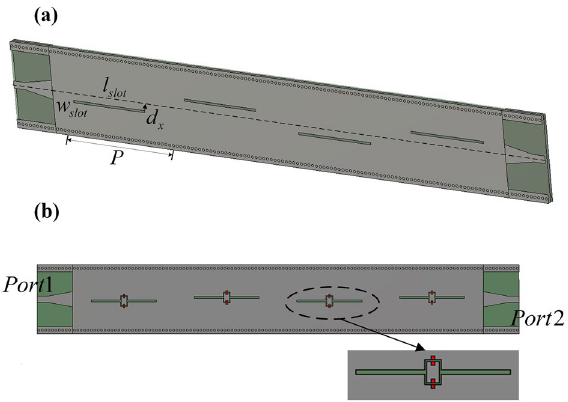
Figure 2. ( a ) The general view of a SIW-based slot antenna without on/off characteristics. Some optimized key parameters (length in mm) are: w slot = 0.5 , l slot = 18.4 , d x = 0.5 , P = 30. ( b ) SIW-based slot array with ideal on/ off characteristics.